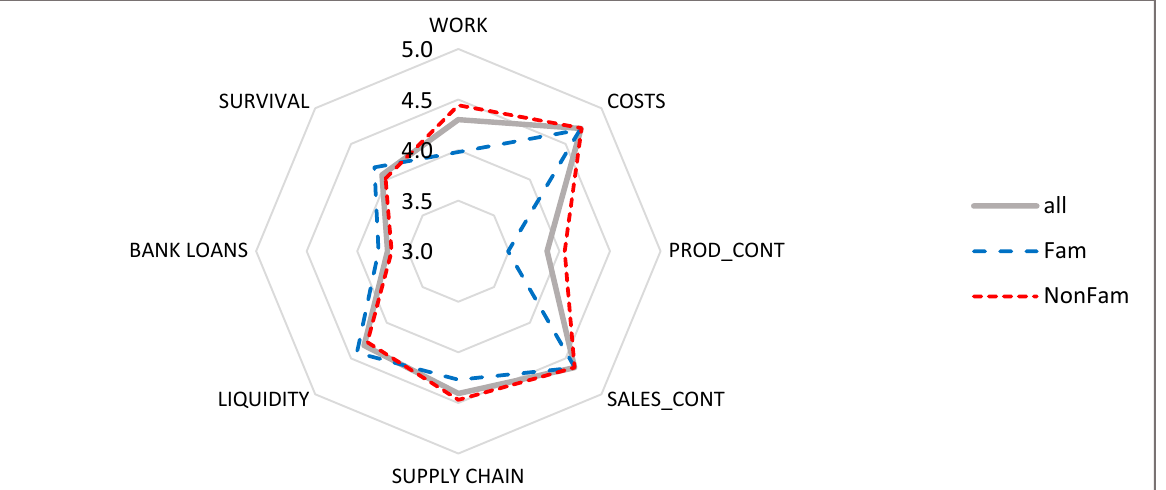
Table 4. Results of k-means clustering: clusters of high, moderate and low COVID-19